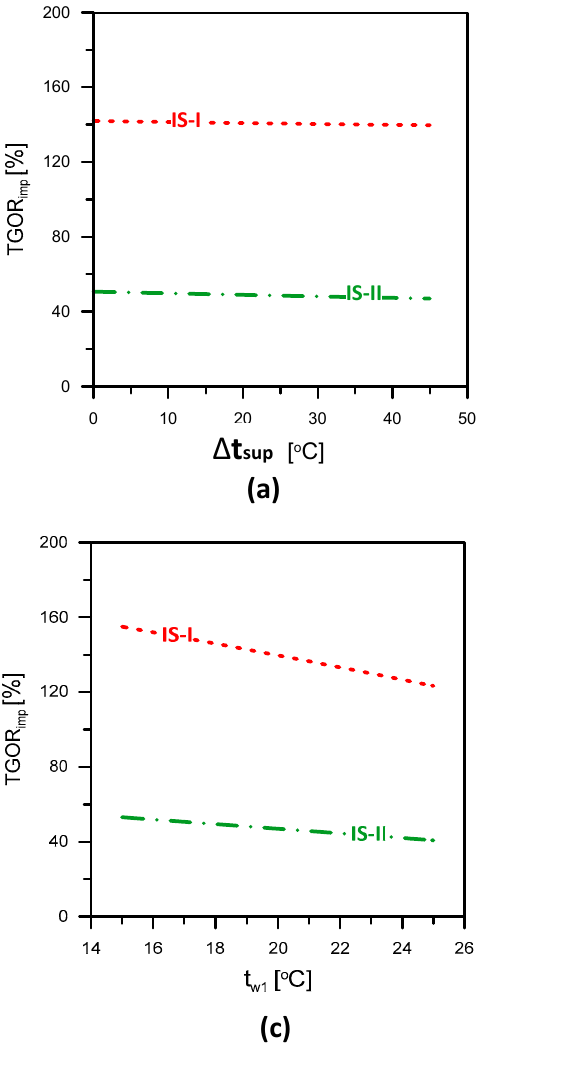
Figure 3. The impact of studied parameters on proposed total output improvements (systems evaluation): ( a ) ∆ t sup ; ( b ) t f1 ; ( c ) t w1 ; ( d ) MR.